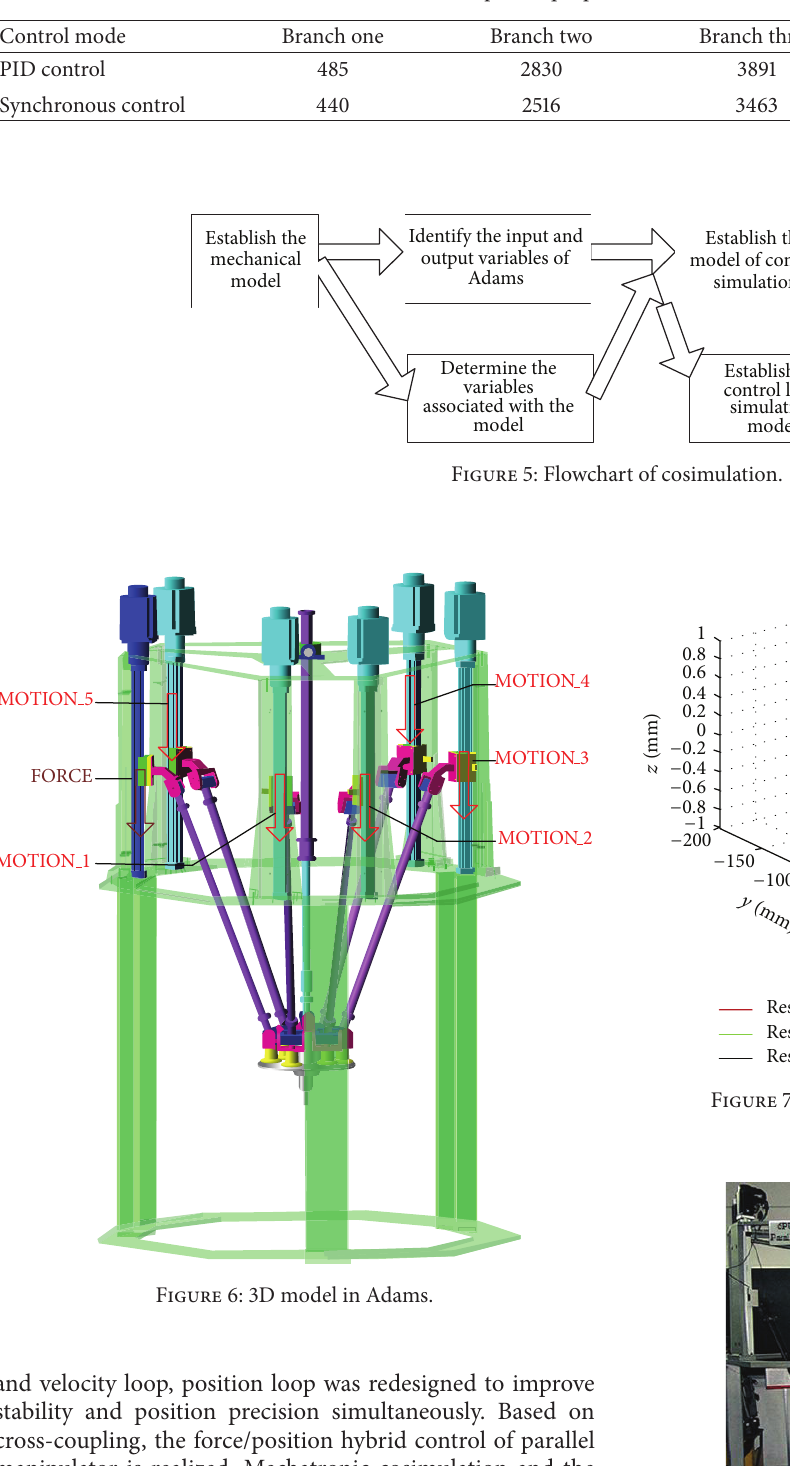
Table 2: Output torque peak table (rounded, unit: Nm).